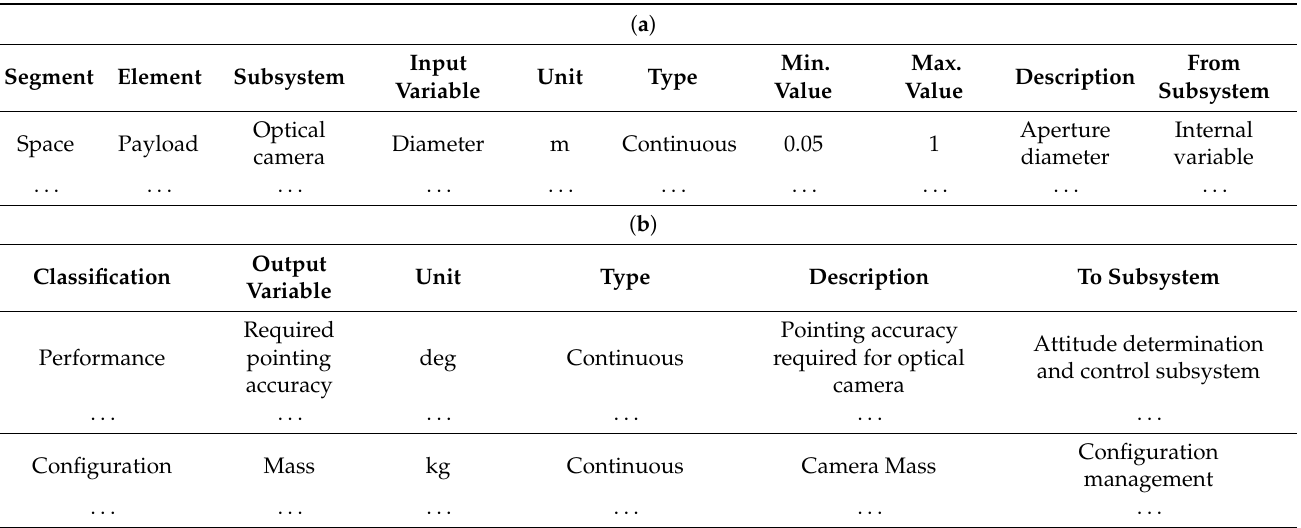
Table 1. Example form of the interface control document: ( a ) inputs section; ( b ) outputs section. ( a